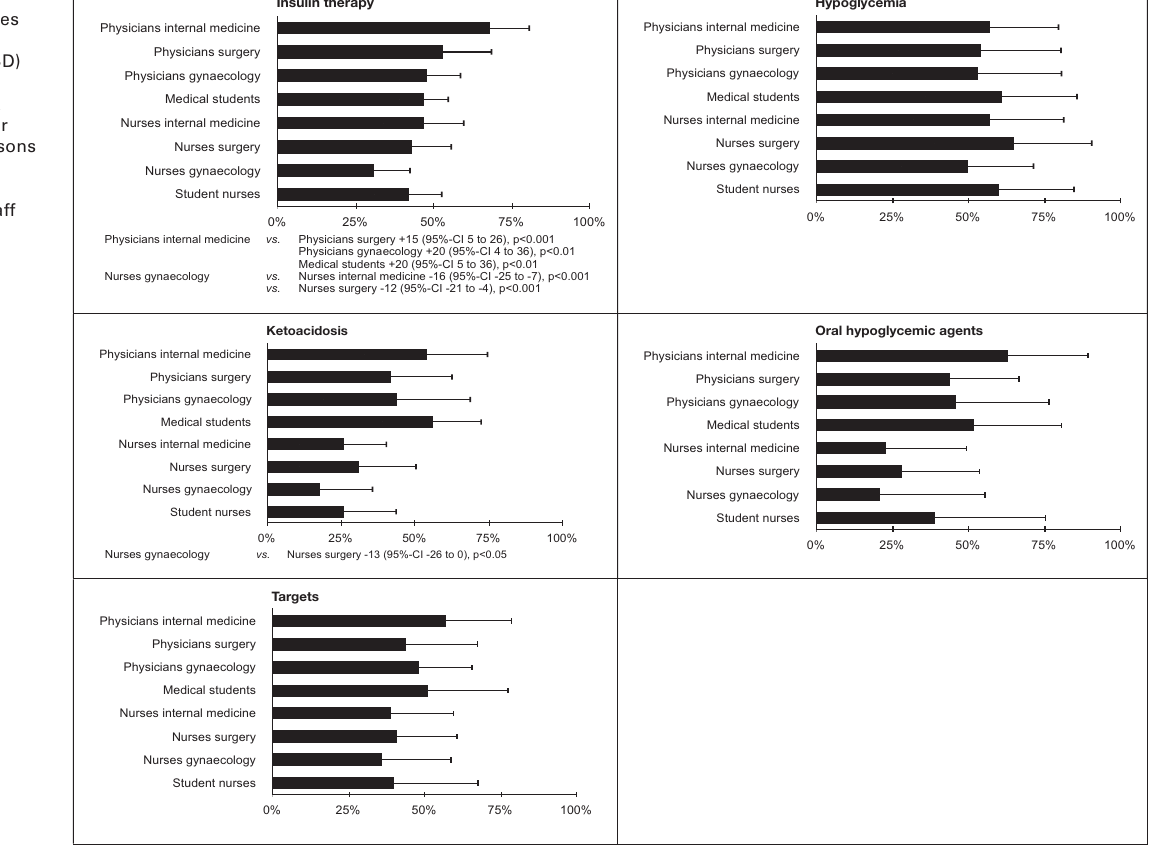
Comfort levels of different study groups (mean ± SD) with relevant statistics (ANOVA withTukey-Kramer multiple comparisons test) in medical house staff and nursing house staff